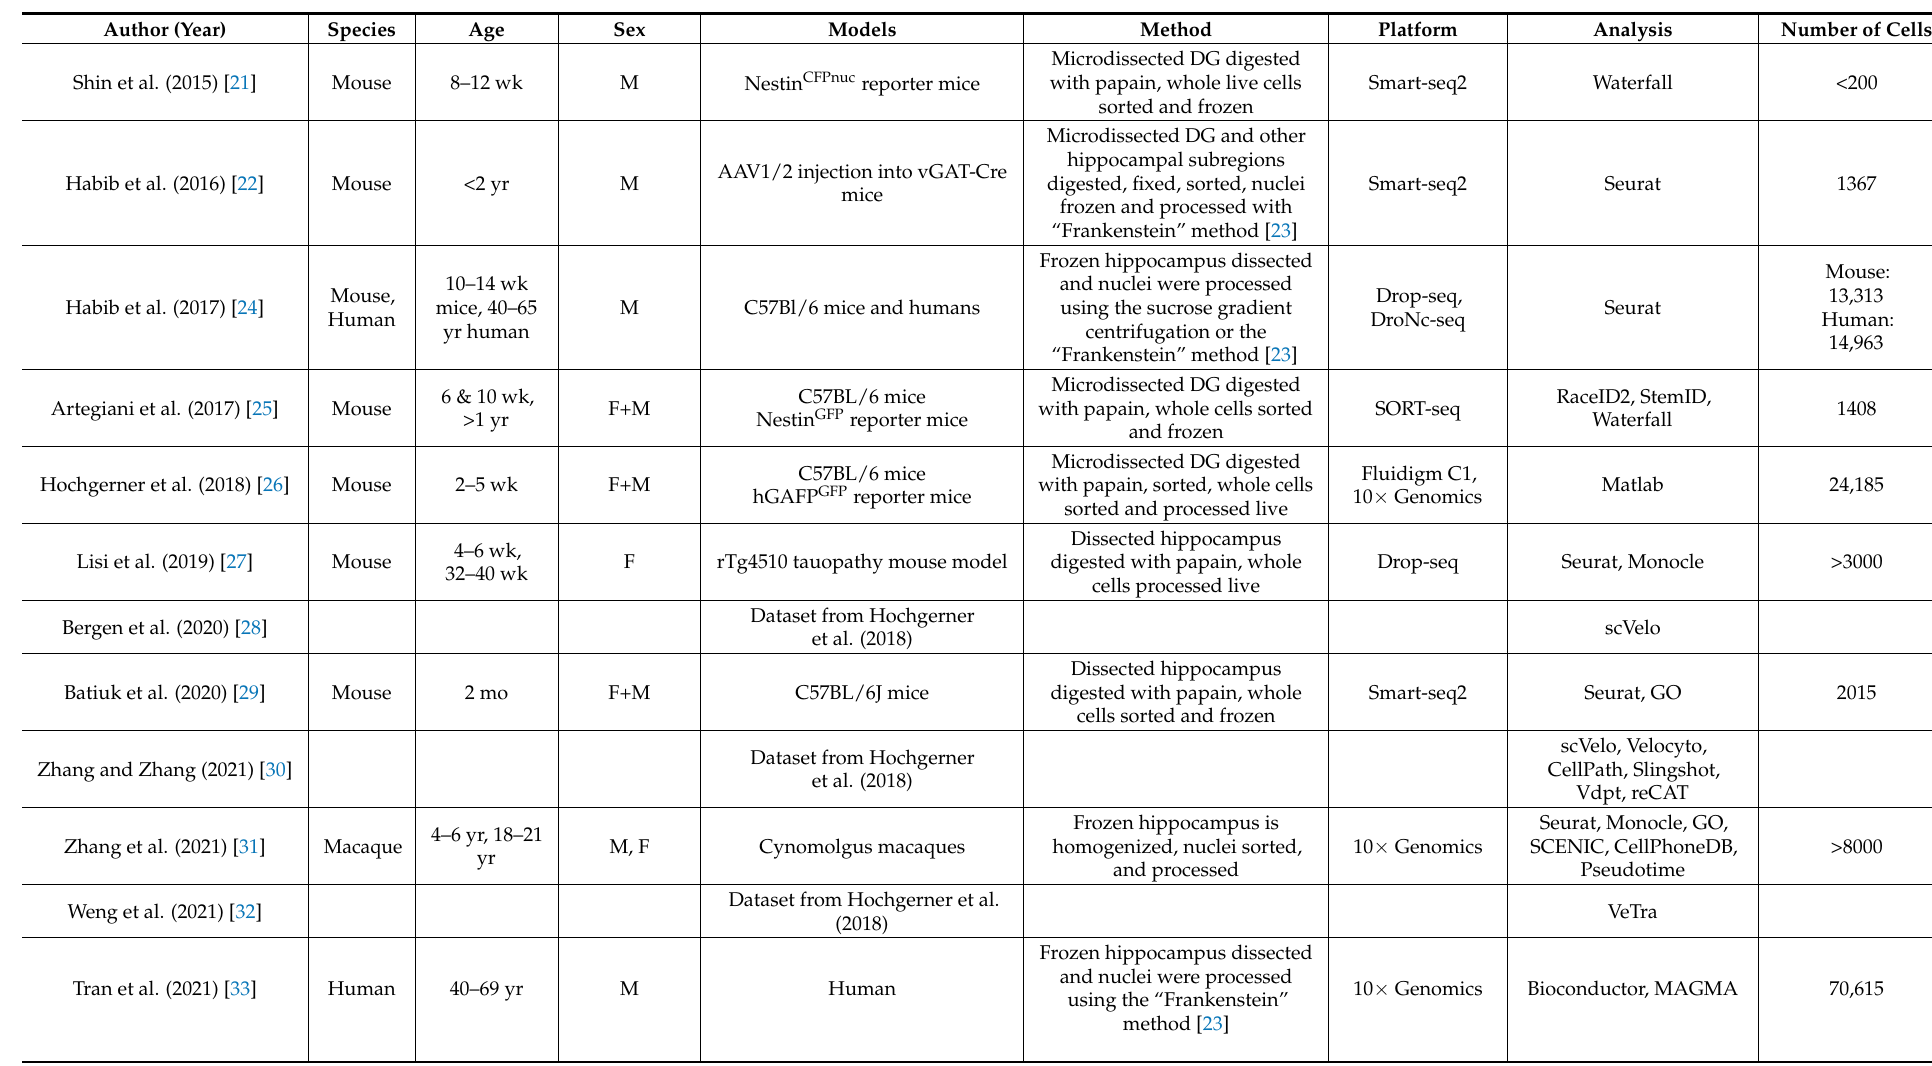
Table 2. Primary literature using sc-RNAseq or sn-RNAseq to assessing adult neurogenesis in the